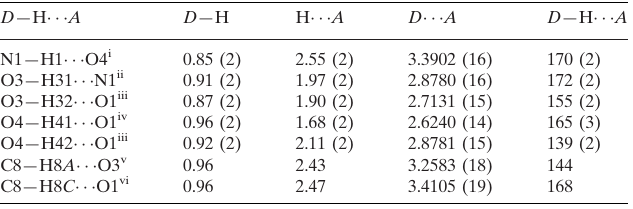
Hydrogen-bond geometry (A˚ , (cid:3)